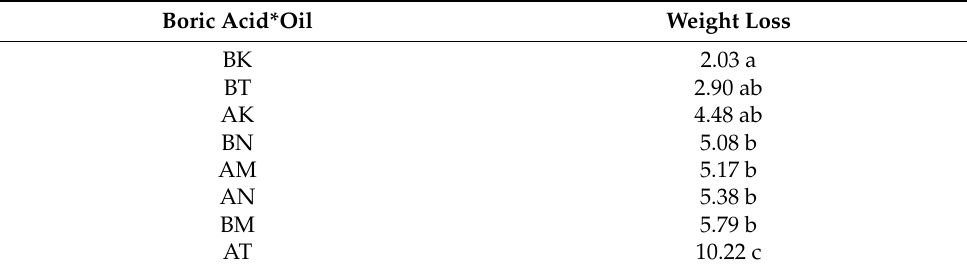
Table 8. Duncan test of weight loss due to subterranean termites.